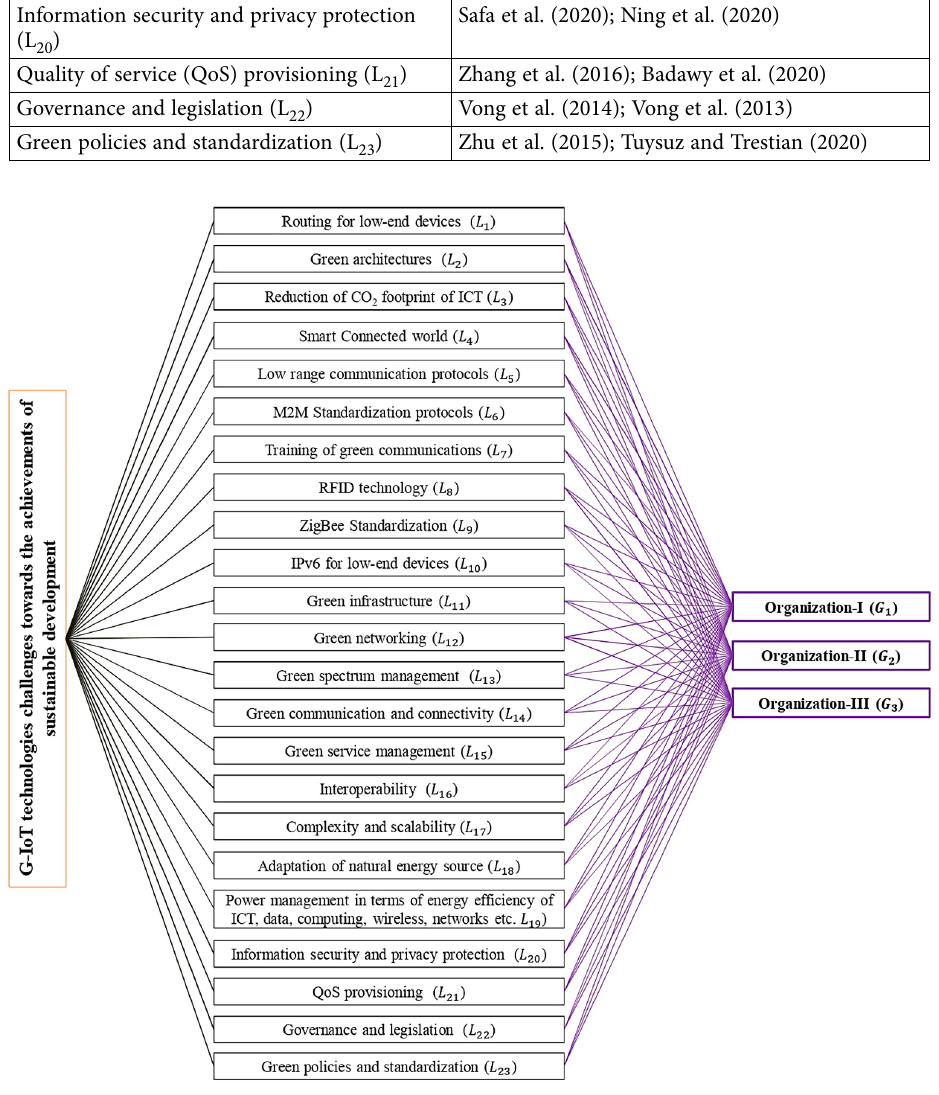
Figure 1. Hierarchical framework of the PF-SWARA-ARAS method to implement of G-IoT